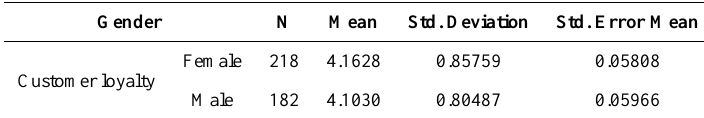
Table 9. Descriptive statistics for gender about customer loyalty